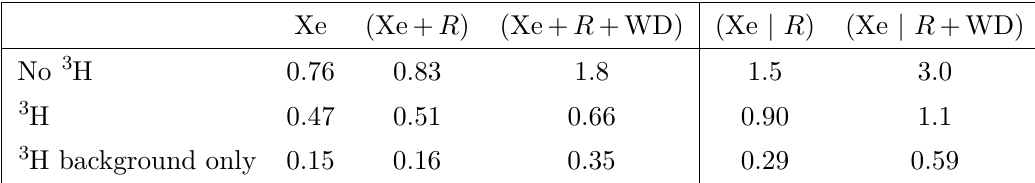
Table 4. Bayes factor in favour of DM ALP versus background, with no tritium background (first row), tritium contributions to the ALP model and background-only model (second row) and tritium contributions only in the background model (third row). We show in the first three columns the results considering Xe, adding the R parameter and finally adding WD hints. The final two columns show partial Bayes factor for the Xe data given the R parameter, and given the R parameter and WD